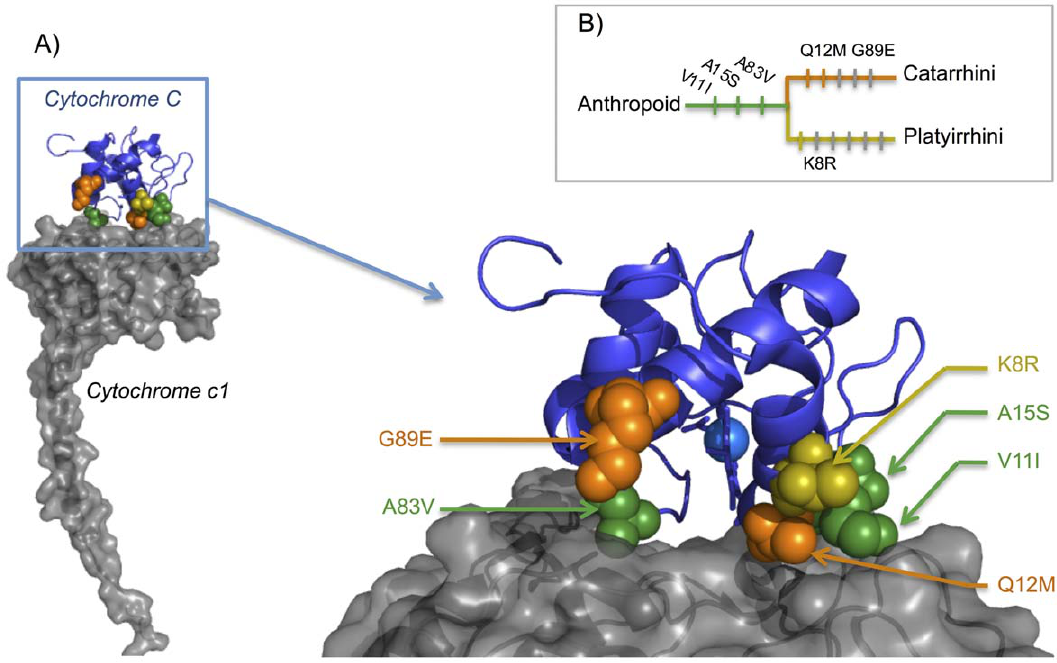
Figure 3. Primate cytochrome c complex III binding site evolution. A) Primates with evolving amino acids shown on the structure of cytochrome c bound on the cytochrome c1 (Yeast, Pdb: 3CXH). Mutation on the Anthropoid root are represented in green, Catarrhini in orange, Platyrrhini in yellow. B) Phylogenic position of amino acid replacements potentially acting on the binding site.